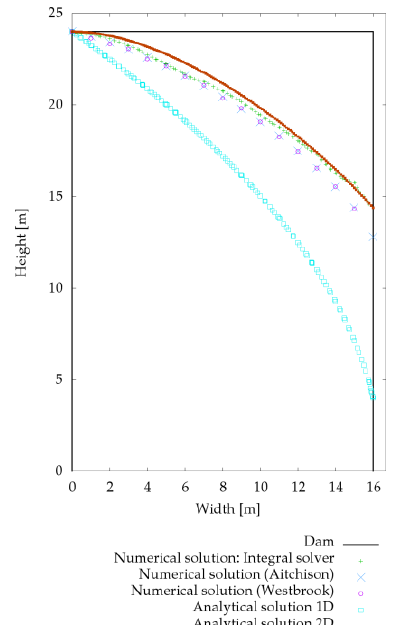
Figure 3. Seepage calculated with 1D and 2D analytical and numerical solutions for a rectangular dam.